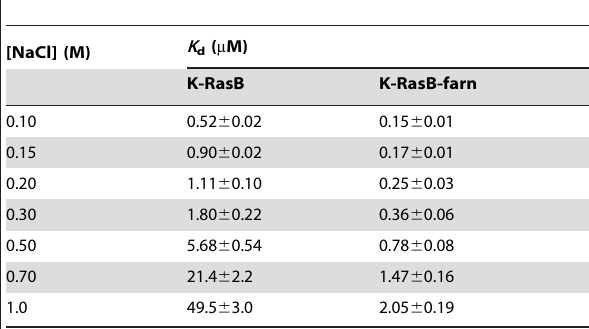
Table 2. Salt concentration dependence of the dissociation constants of K-Ras K-Ras-farn binding to CaM as determined by dansyl-CaM fluorescence titration at 25.0 u